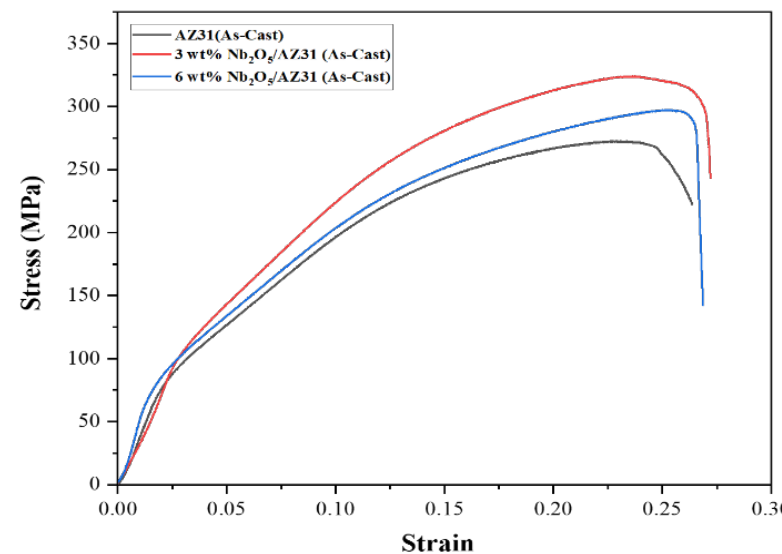
Figure 9. Compressive strength of Nb 2 O 5 /AZ31 composites. Table 3. Shows peak stress, fracture strain, and microhardness.